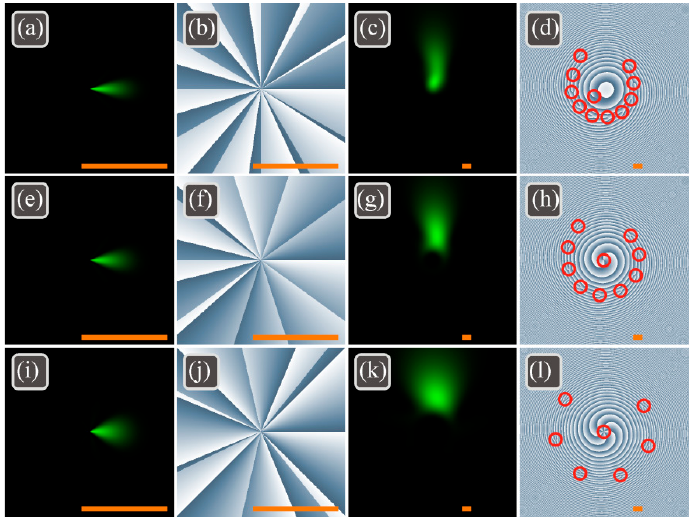
Figure 3. The intensity (columns 1 and 3) and the phase (columns 2 and 4) distributions of the light field (1) with n = 11, k = 0 ( a – d ), k = 2 ( e – h ), k = 5 ( i – l ), m = 1, a = 1, w 0 = 500 μ m in the initial plane z = 0 ( a , b , e , f , i , j ) and in the far field z = 2 z 0 ( c , d , g , h , k , l ). The red circles in phase distributions ( d , h , l ) highlight the OVs. The scale mark in each figure corresponds to 1 mm.